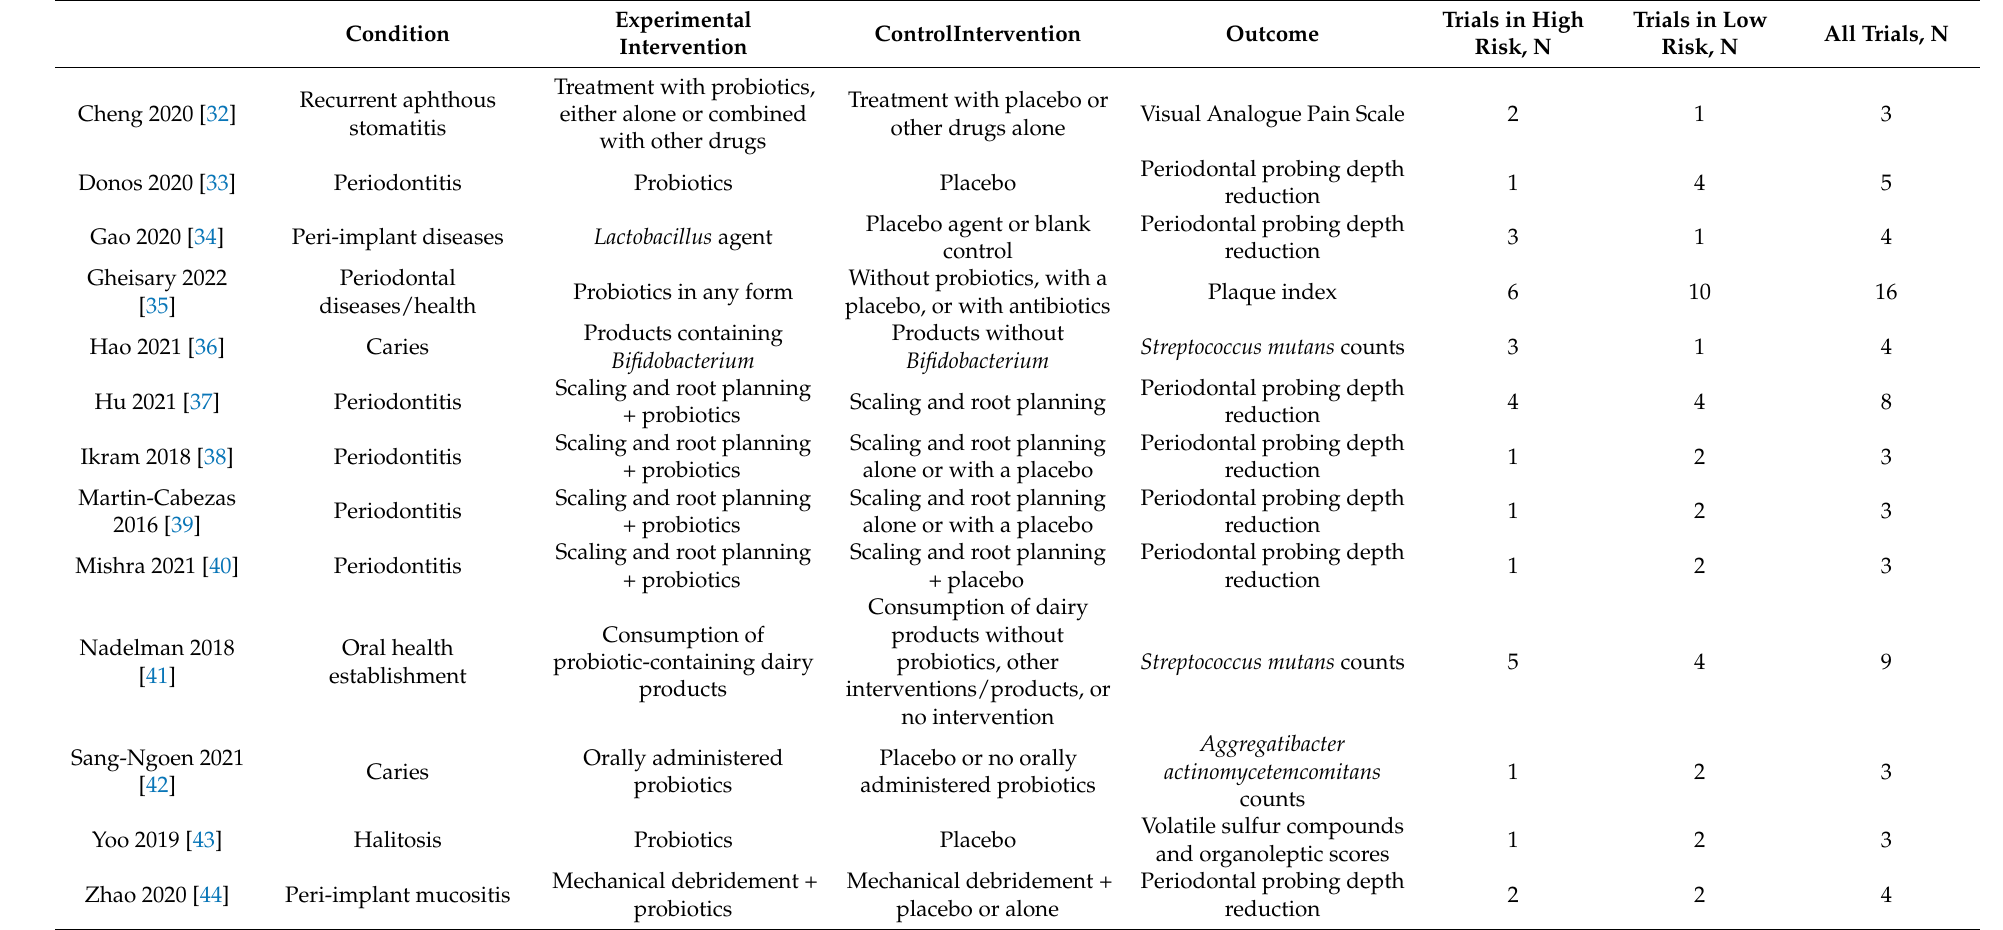
Table 1. Characteristics of included